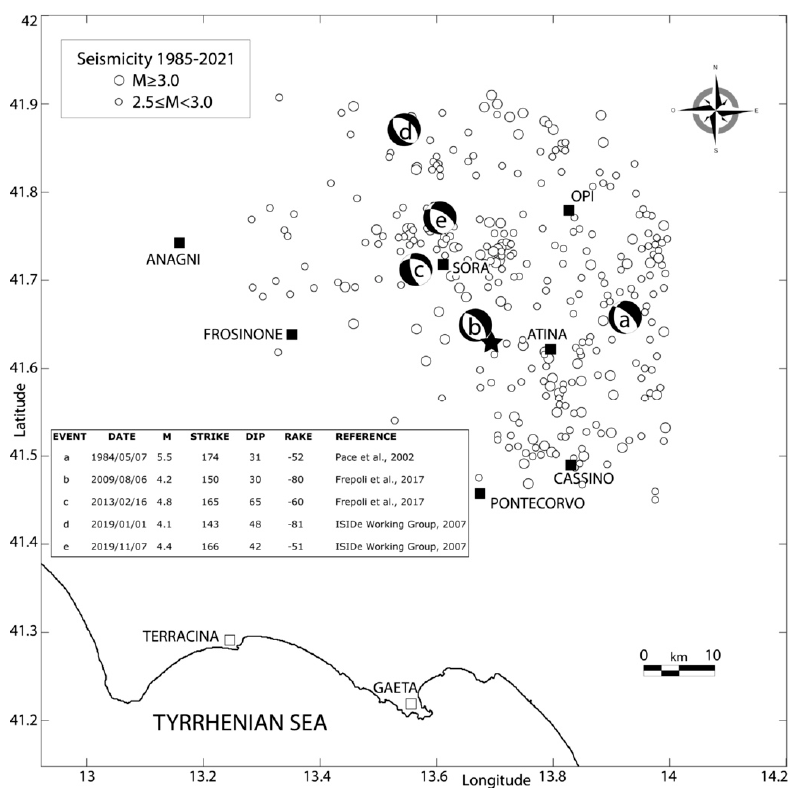
Figure 4. M ≥ 2.5 instrumental seismicity from 1985 [10] in the area of the 1654 earthquake (Latitude 41.45-41.90°, Longitude 13.30-14.00°). In the inset, we show the parameters of the five M > 4 instru- mental earthquakes that occurred in the area since 1984. A black star indicates the macroseismic epicenter of the 1654